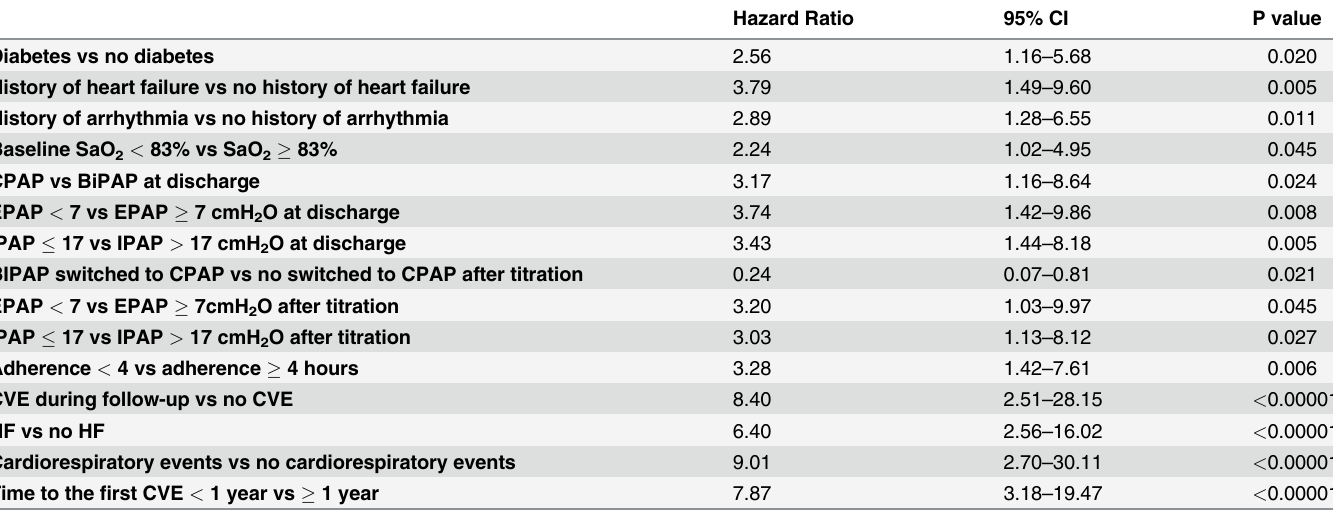
Table 3. Univariate analysis of risk factors related to mortality in OHS patients.